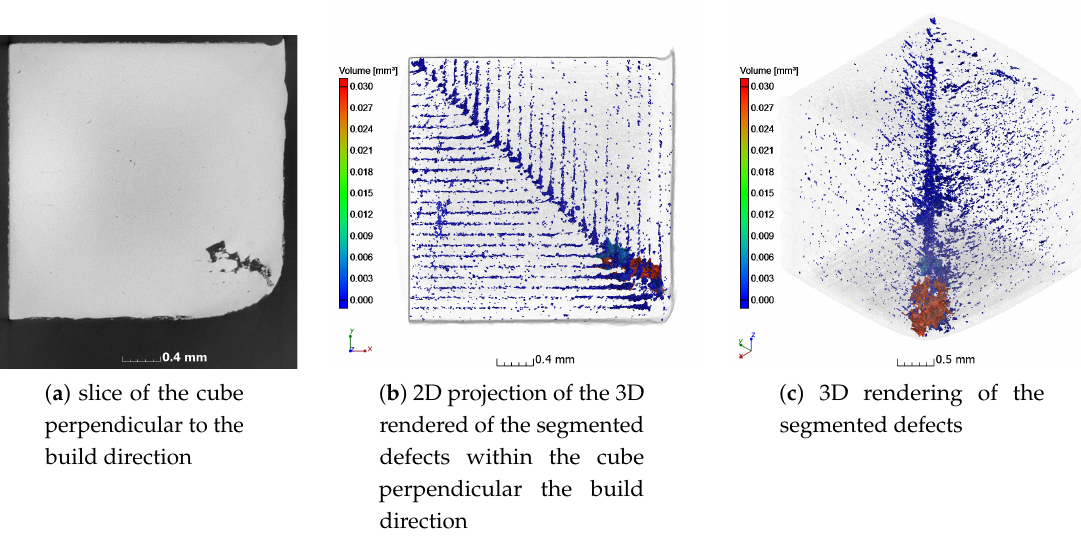
Figure 6. µ CT reconstructions of the ND reference cube sectioned from a twin PtC specimen ( (cid:112)(cid:72)(cid:113)